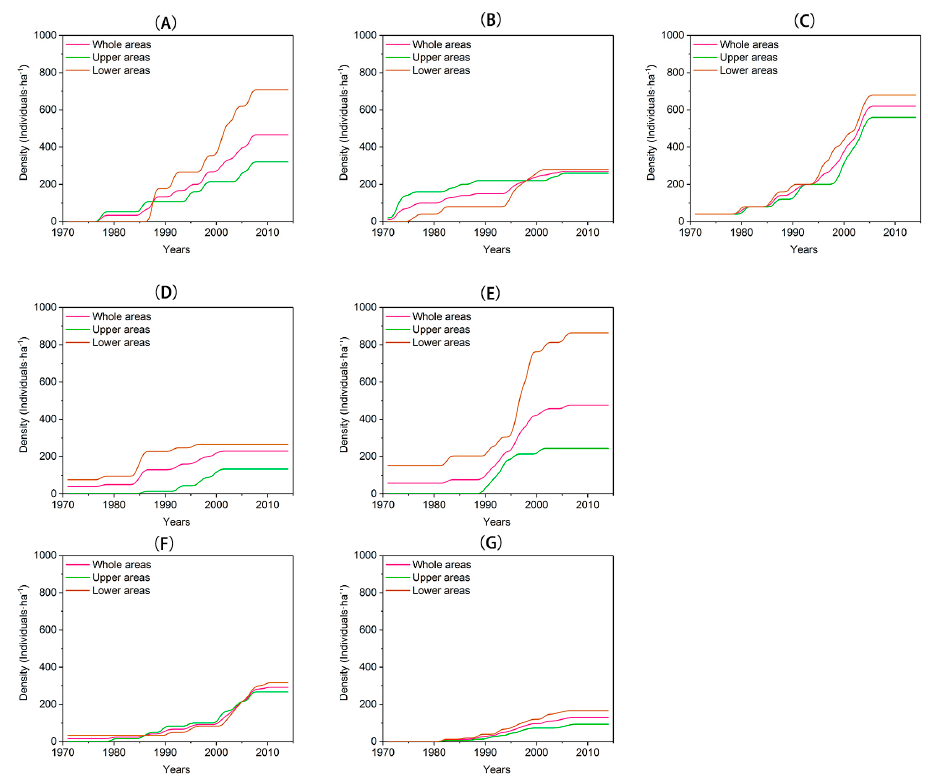
Figure 6. Population density dynamics of Larix within different sampling site in the alpine treeline ecotone in the Eastern Tibetan Plateau during the period of 1971–2014 (( A ): site N1; ( B ): site N2; ( C ): site N3; ( D ): site N4; ( E ): site N5; ( F ): site S1; and ( G ): site S2). The pink, green, and brown lines show the density dynamics in the whole, upper, and lower areas, respectively.